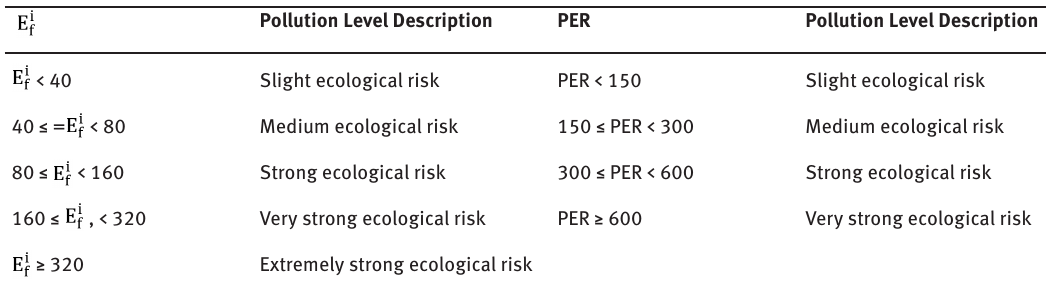
Table 1: Risk value and risk degree